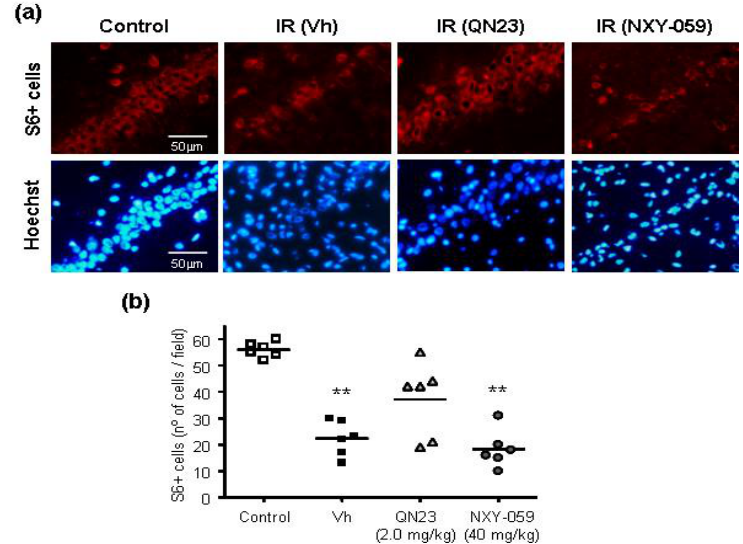
Figure 7. Study of the long-term effect of QN23 after cerebral ischemia–reperfusion by neuronal viability assessment. Brain sections from control animals (control) or from animals treated with vehicle (Vh), QN23 (2.0 mg/kg), or NXY-059 (40 mg/kg) by intravenous injection at the reperfusion onset after ischemia were evaluated for immunostaining at 11 weeks after ischemic reperfusion (IR). Neurons were labeled with anti-S6 protein antibody and X Red-secondary antibody and visualized by fluorescence microscopy (in red). Cell nuclei were counterstained with Hoechst dye (in blue). ( a ) Representative images of the hippocampal CA1 region. ( b ) Dot graph representation of S6-labeled cells (S6+ cells) per field of the hippocampal CA1 region from control animals and vehicle (Vh)-, QN23-, and NXY-059-treated animals after 11 weeks of post-ischemic reperfusion. Individual values of 6 independent animals per group are shown and the horizontal line represents the mean. ** p < 0.01, compared with the control group by Dunnett’s post-test after ANOVA.